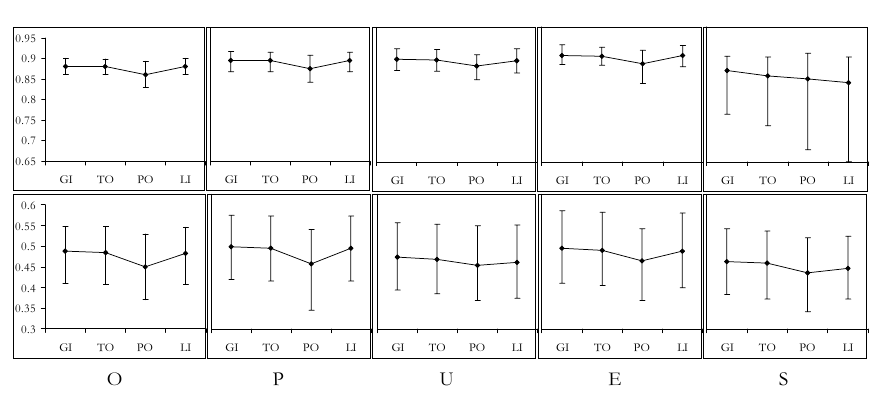
Figure 2 – MGM mean correlations µ 11 (row 1) and µ 22 (row 2), with the associated ranges, of the m i variables with the subscale to which they were a priori assigned to, obtained by the four scoring methods GI (Gifi), TO (Torgerson), PO (Portoso) and LI (linear assignment) for each discretization type ( O =optimal, P =pseudo-optimal, U =U-shape, E =equal, S =skew), with reference to the data set with λ 1 =0.9 and λ 2